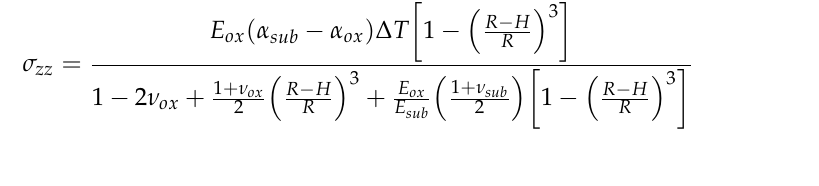
where σ ii are the hydrostatic components of the stress tensor and Π ii are the components of the piezospectroscopic tensor ( Π ii = 7.60 cm − 1 /GPa for α -Al 2 O 3 ) [26]. For a flat scale, the stress can be assumed to be biaxial, i.e., σ xx = σ yy = σ and σ zz = 0. Therefore, the biaxial stress can be determined by ∆ ν = 5.06 σ . However, for a curved alumina scale, the component σ zz normal to the sample surface is no longer zero and the in-plane stress components σ xx and σ yy are expected to vary from place to place, depending on the geometry of oxide. For a spherically symmetric geometry like the spherical indent in this study, an analytical solution for the thermal mismatch stress is obtained as